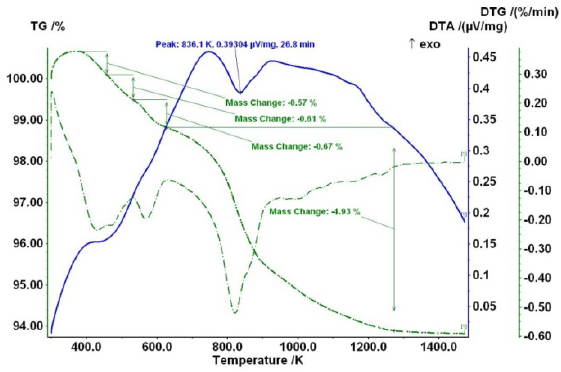
Figure 1. Phase composition of the “ Čavka ”